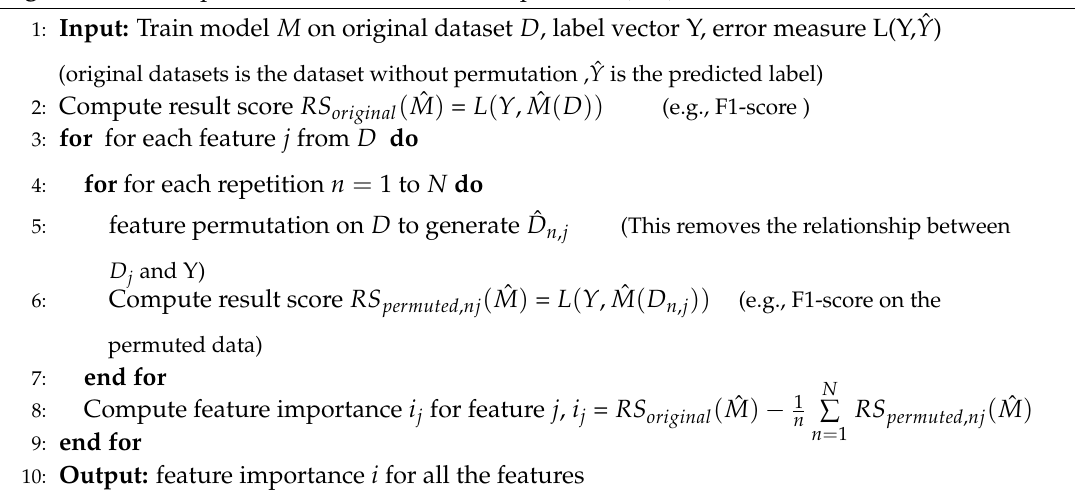
Algorithm 2: Compute Permutation Feature Importance (PFI)